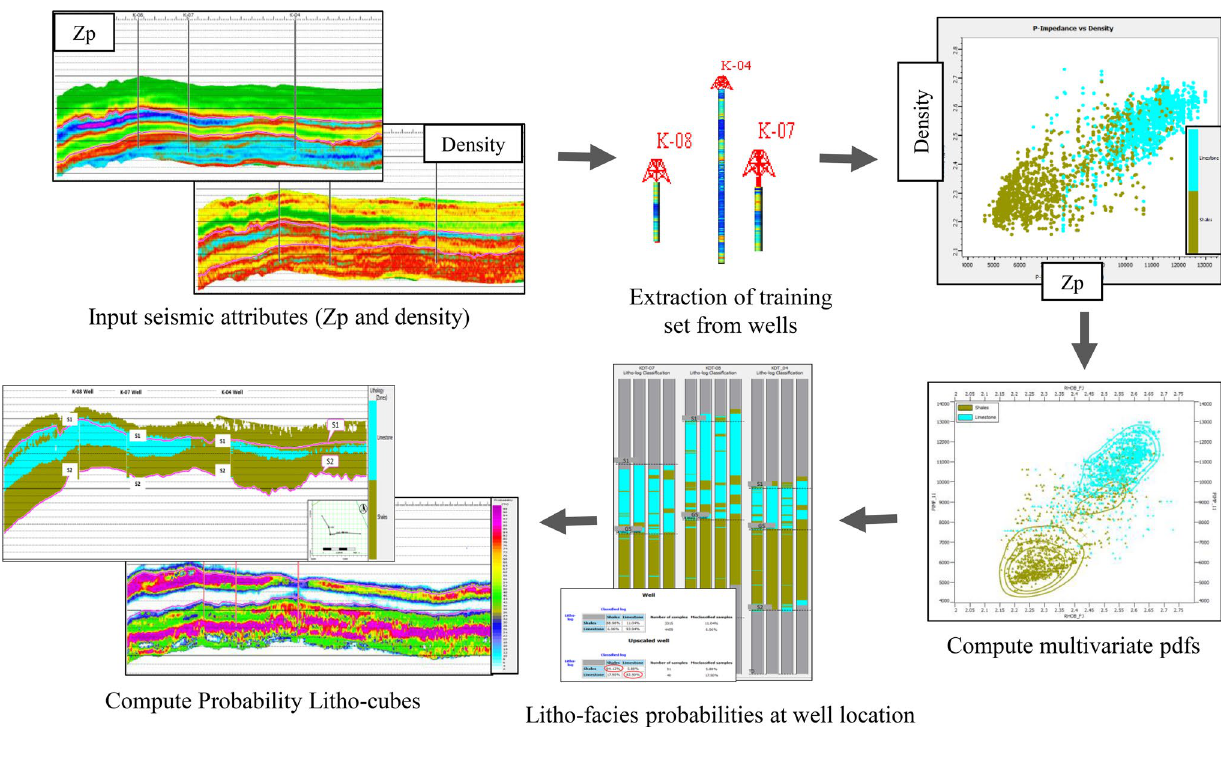
Fig. 17 Schematic workflow for the litho-facies prediction from seismic inversion